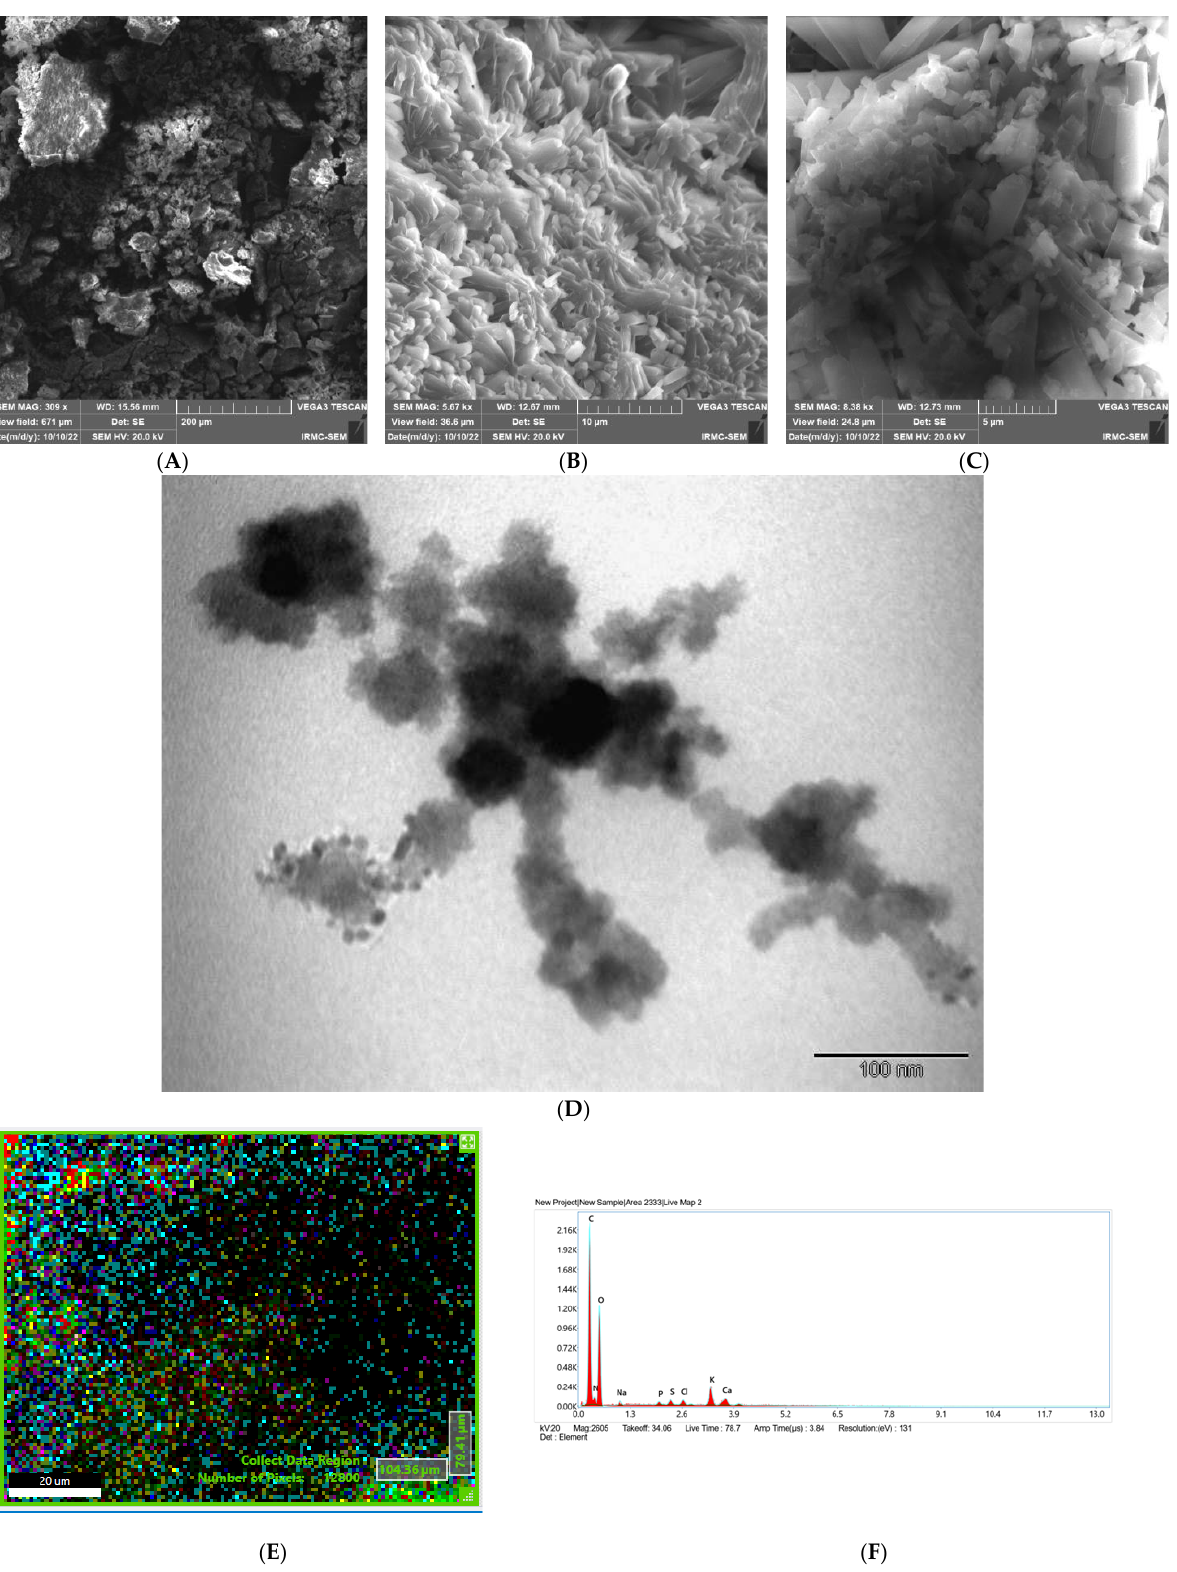
Figure 2. Morphological analysis of lyophilized amikacin sulfate loaded dextran nanoparticles (LADNP)/( A ) Scanning electron micrograph of LADNP ( B , C ) Crystalline structure of LADNP captured using scanning electron microscope ( D ) Transmission electron micrograph of LADNP ( E ) EDAX analysis of LADNP, the area under scanning ( F ) EDAX graph of